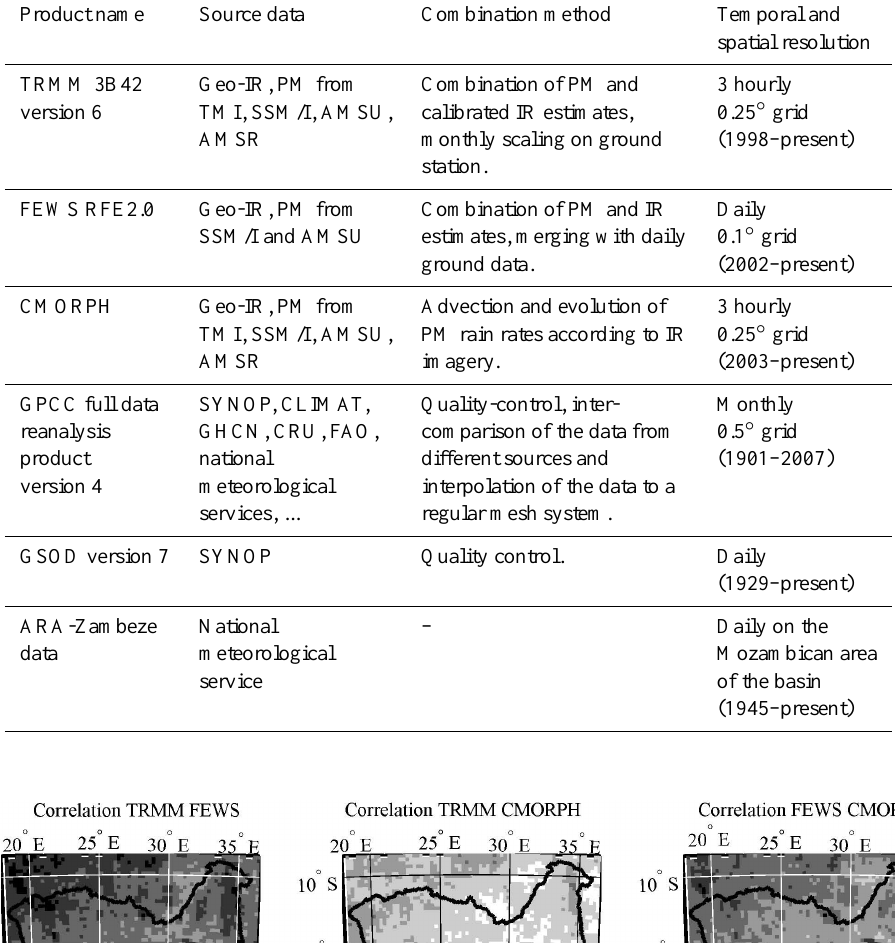
Table 1. Summary of the precipitation products used in this study with input data type, combination method and spatial and temporal resolution.